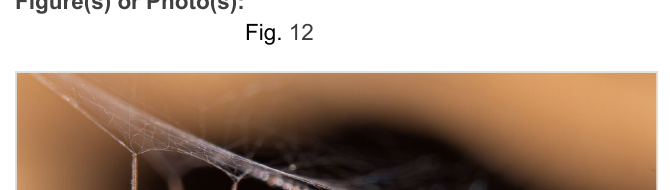
Troglohyphantes pluto Caporiacco, 1938. Photo credit: Francesco